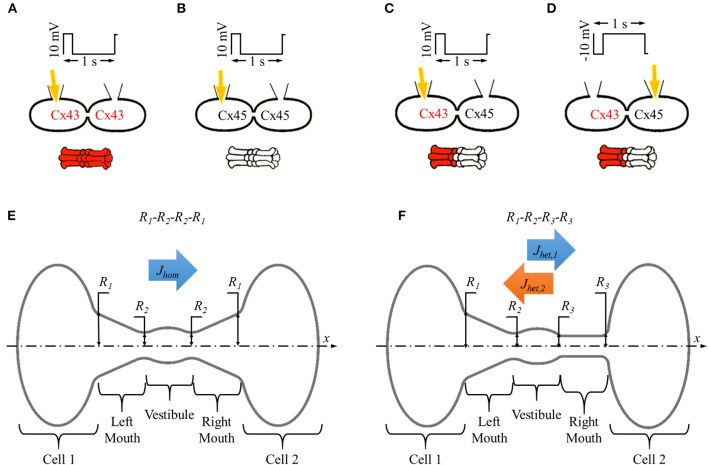
In vitro
and in silico experiment designs with homotypic and heterotypic gap junction pores. (A–D) Basic setup for in vitro dye diffusion experiments under double whole cell voltage clamp with homotypic (A) Cx43 and (B) Cx45 gap junction pores and (C,D) heterotypic Cx43-Cx45 gap junction pores with LY (yellow arrow) injected from (C) Cx43 side and (D) Cx45 side. Voltage pulses of 10 mV/200 ms/1 s were applied and LY dye diffusion was recorded across the gap junction. (E,F) Simulation experiment design for single (E) homotypic and (F) heterotypic gap junction pore. The cell-pore-cell system was divided in 5 sections: (1) cell 1, (2) left mouth, (3) vestibule (4), right mouth, and (5) cell 2.